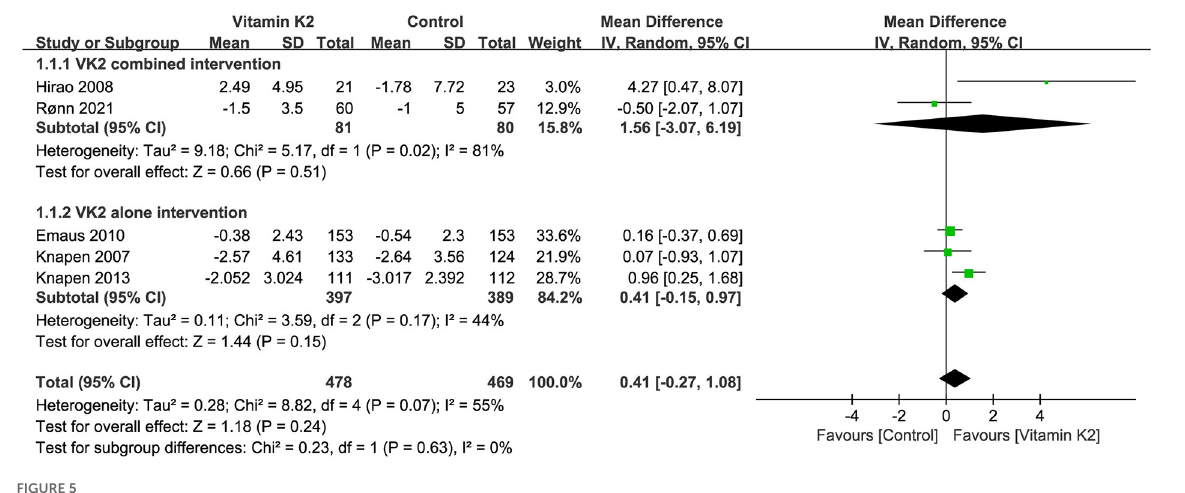
FIGURE5 Forest plot of the change in femoral neck BMD.